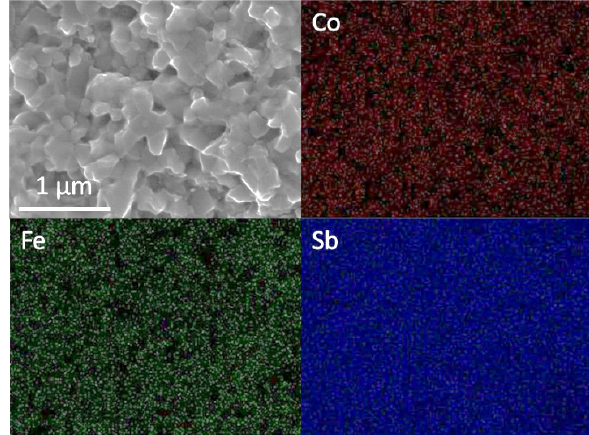
Figure 3: SEM micrograph and EDX elemental map of the sample KTH_12.